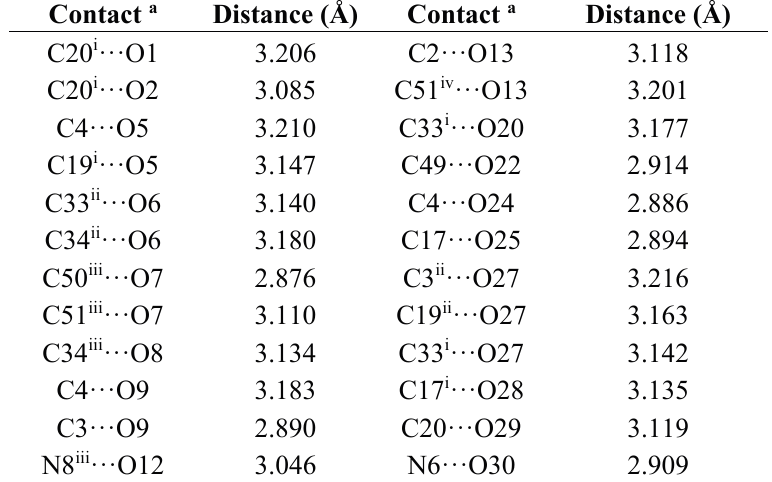
Table 2. Short contacts between W 10 and the heterocyclic moiety of C 12 pda in 1 . Contact a Distance (Å) Contact a Distance (Å) C20 i